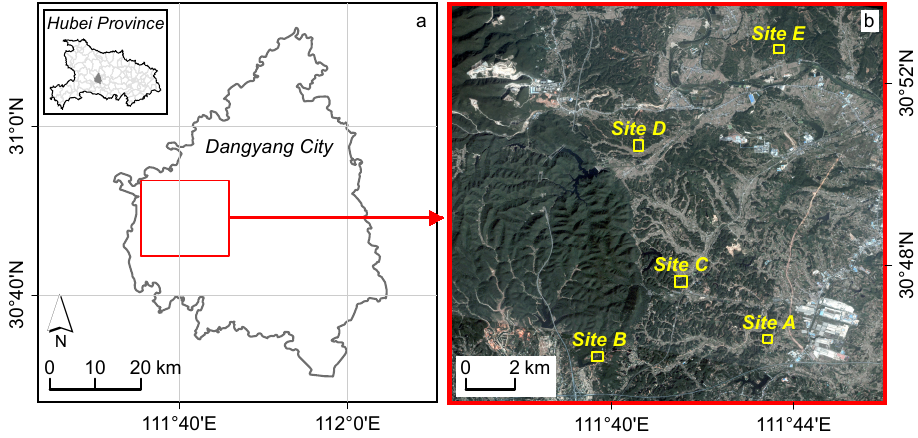
Figure 1. Overview of the study area and field sites. ( a ) The study area located in Dangyang City, Hubei Province. ( b ) A thumbnail graph of the PlanetScope satellite image and the spatial distribution of the five field